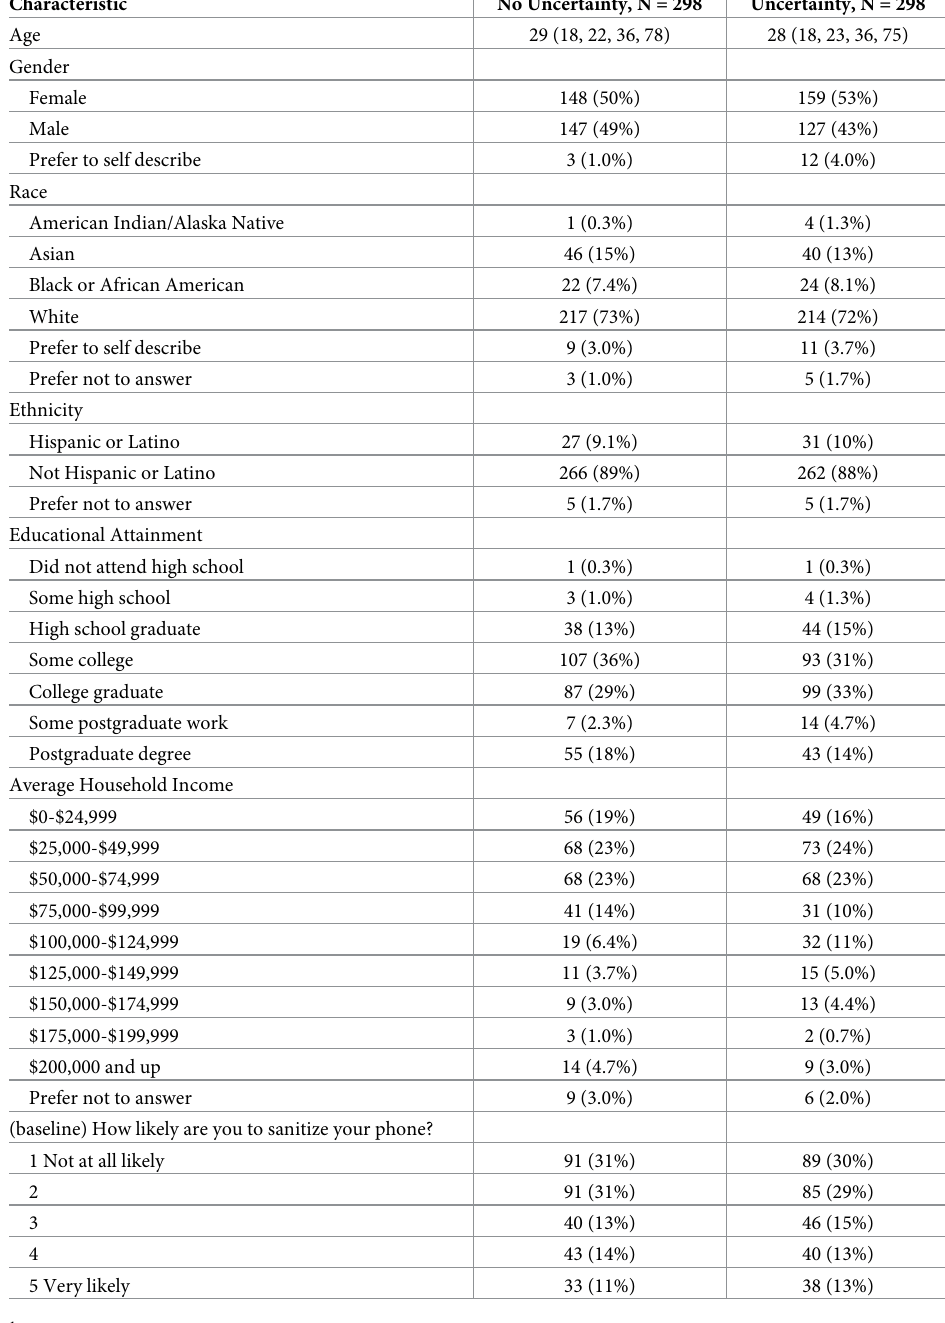
Table 1. Baseline